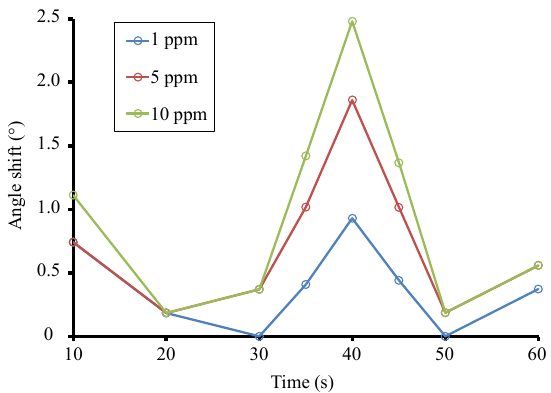
Fig. 3 Response of SPR signals with respect to time at different As(V) concentrations.